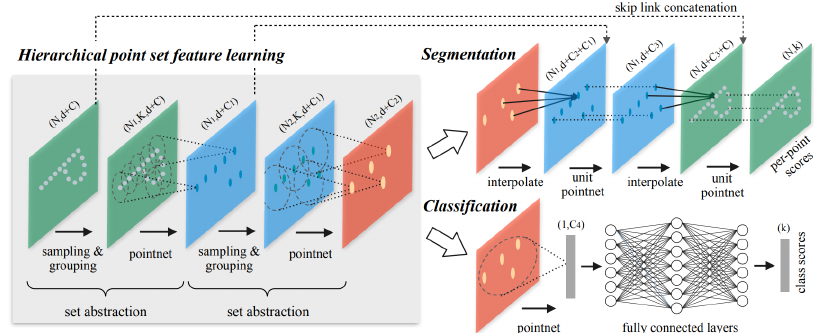
Figure 7. PointNet++ architecture. Hierarchical feature learning is introduced to learn features at various scales. Sampling and grouping layers define and sample neighbourhoods at various sizes which are fed into a mini-PointNet architecture for feature extraction. Image source: